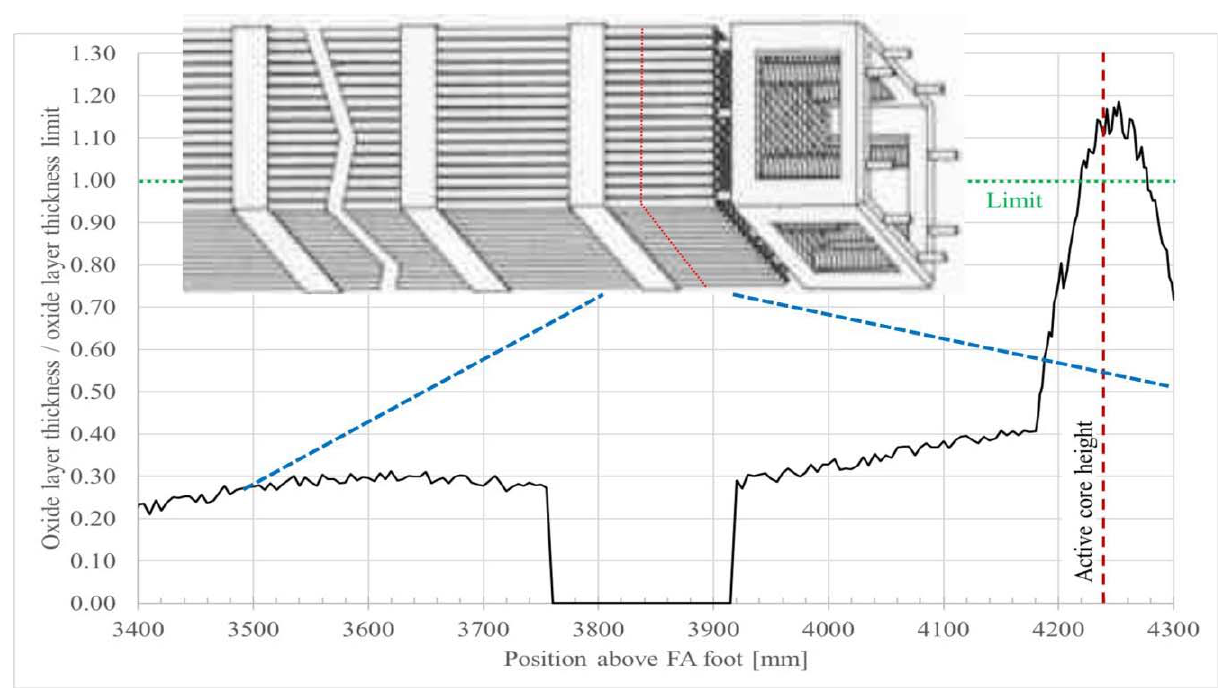
Figure 4. Example of a measured Oxide Layer